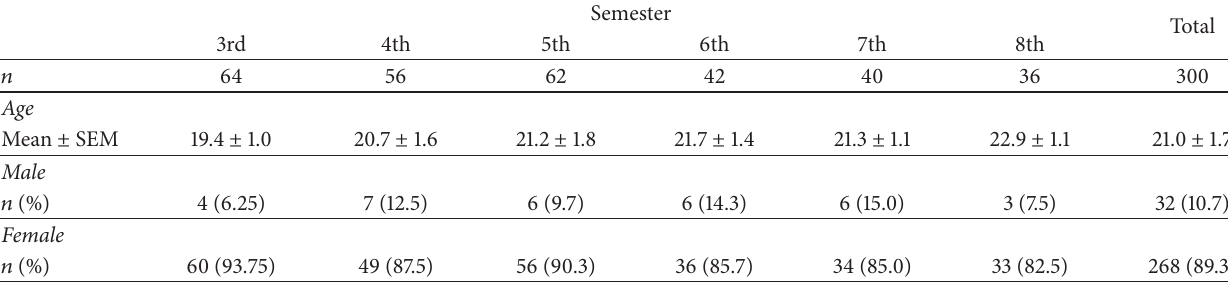
Table 5: Age and gender of the nursing students of different semesters.